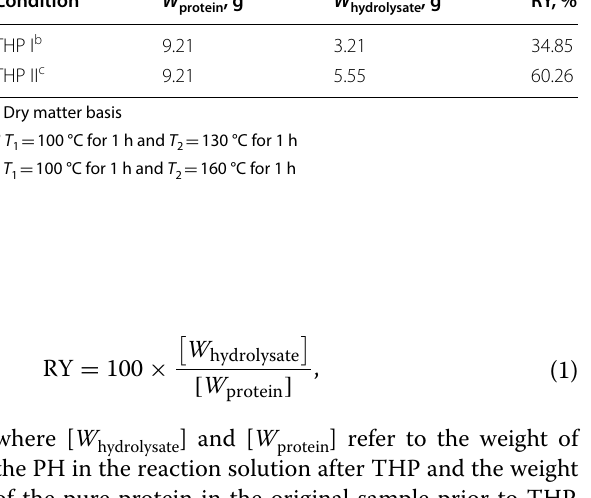
Dry matter basis a Alkali metals such as Na, Ca, and Mg b The leftover solid after THP recovered by filtration by a screen with 90 mm mesh, dried in an oven overnight, and ground by a pestle for analysis